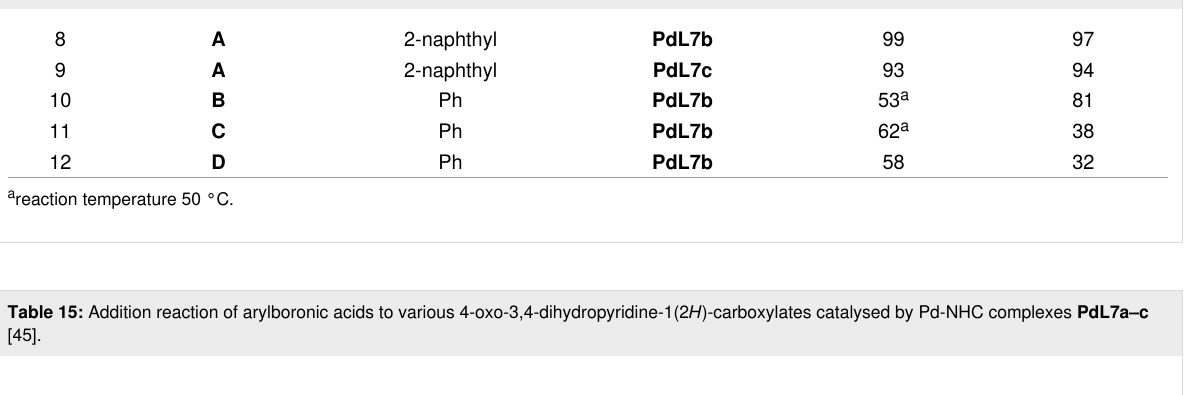
Table 14: Addition reaction of arylboronic acids to different enones catalysed by Pd-NHC complexes PdL7a–c [44,45]. (continued)